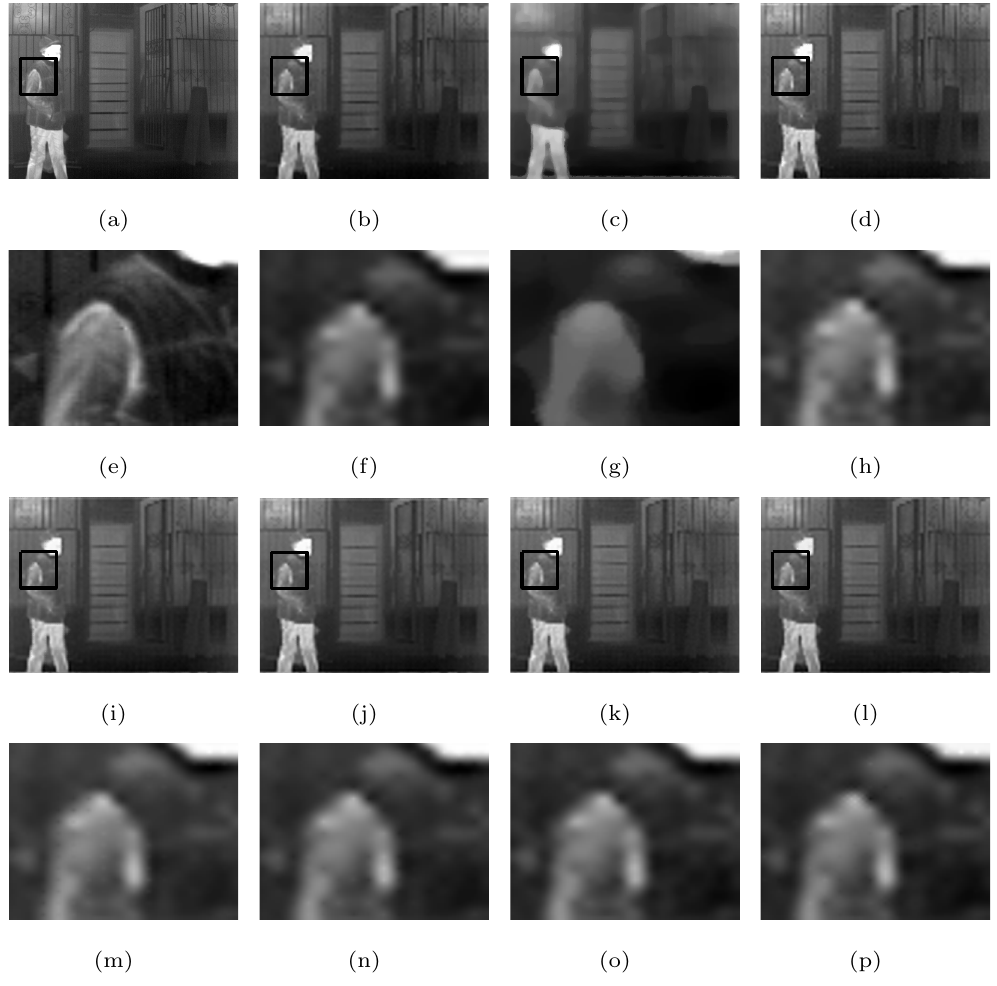
图 1: description of figure Figure 6. Super-resolution x4 results of the LR passerby images without noise; ( a – d , i – l ) ground truth and the results of the Bicubic, MFT, TV, TGV, TV4, FTV4, and FTV4Lp methods, respectively; ( e – h , m – p ) enlarged details from the rectangles in ( a – d , i – l ),